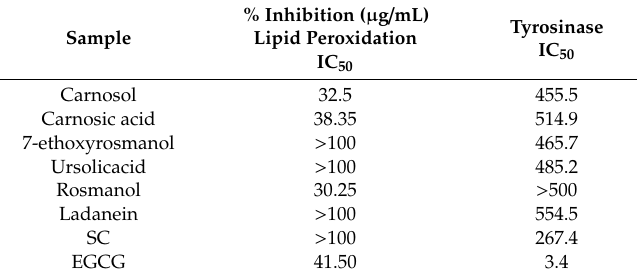
Table 3. E ff ects of S. chamelaeagnea constituents on inhibition of Fe (II)-induced microsomal lipid peroxidation, anti-tyrosinase activities.